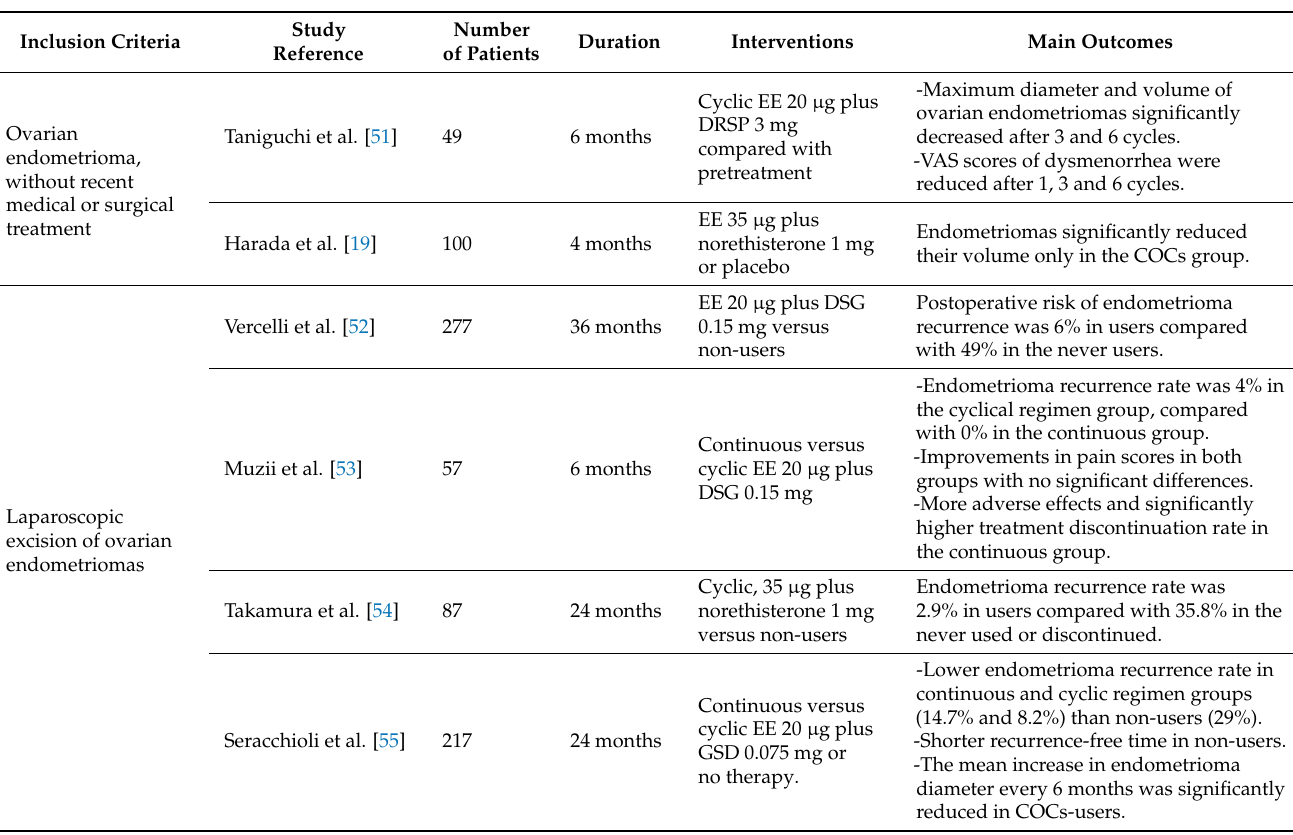
Table 2. Estrogen-progestin and endometrioma. Summary of studies evaluating efficacy of COCs fot the treatment of endometriomas larger than 3 cm in diameter with or without recent surgical treatment. Regrowth of residual lesions or formation of de novo lesions are responsible for the recurrence rate of endometrioma between 30% and 50%. Thus, COCs have been recommended as first-line hormonal treatment in clinical practice guidelines for the treatment and prevention of endometrioma